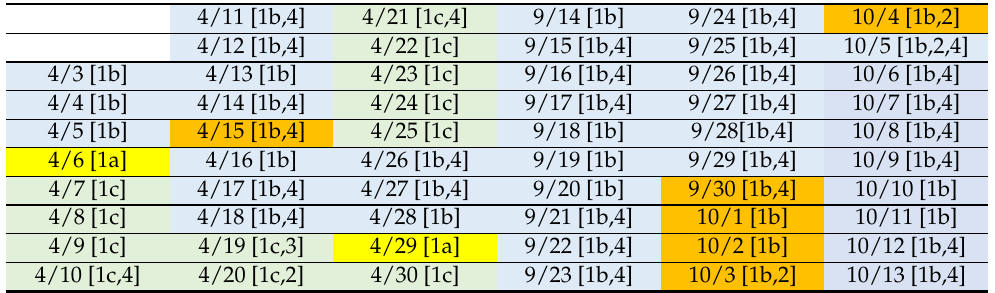
Colors in cells represent sea breeze types: yellow—pure; blue—corkscrew; green—back-door; brown— special